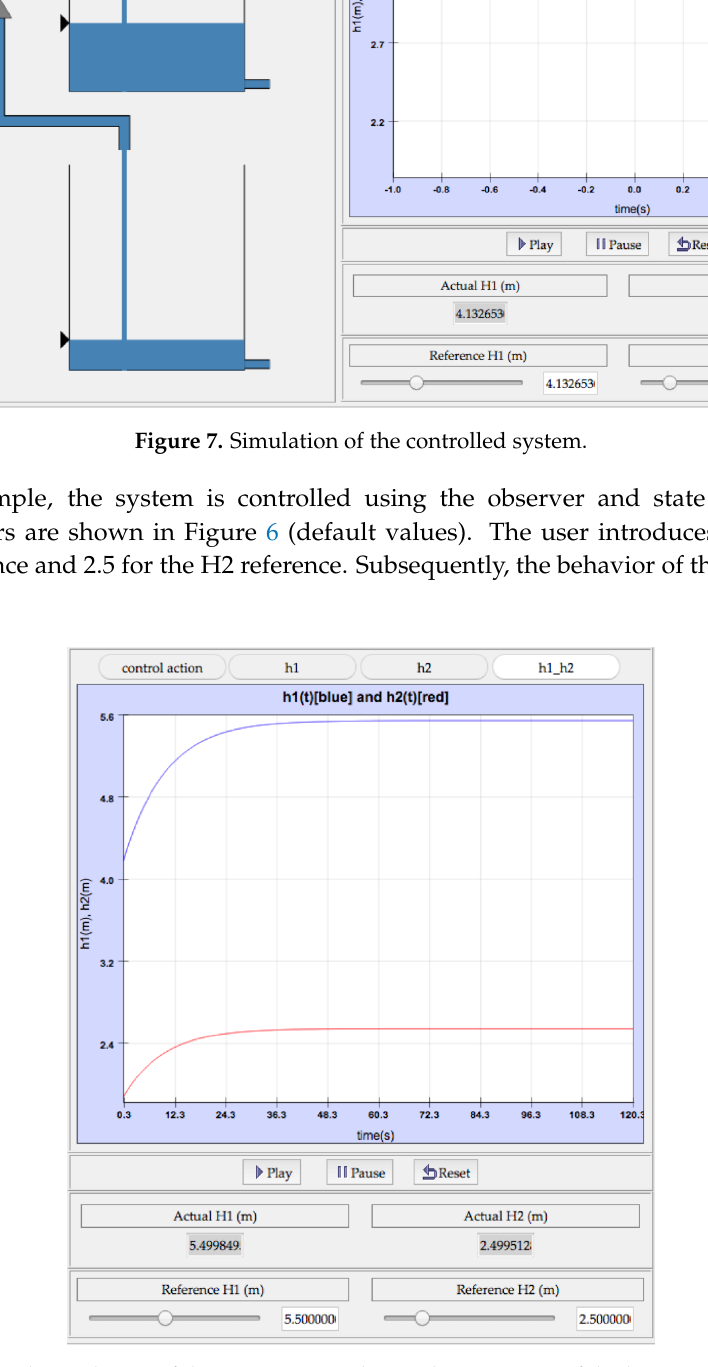
Figure 8. The evolution of the outputs considering the equations of the linearized